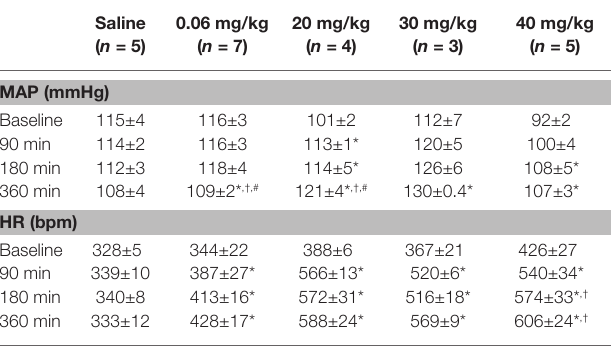
TABLE 1 | Time course of mean arterial pressure (MAP) and heart rate (HR) response to different doses of lipopolysaccharide.